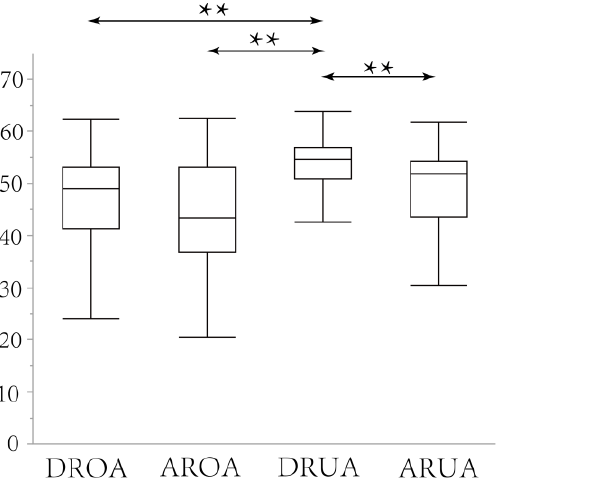
Figure 2. Processing of questionnaire date.